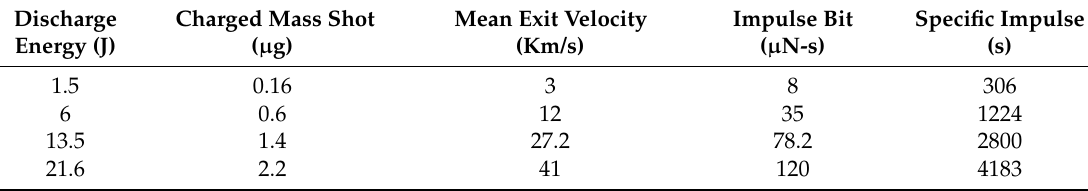
Table 4. Discharge energy variation effects on performance of